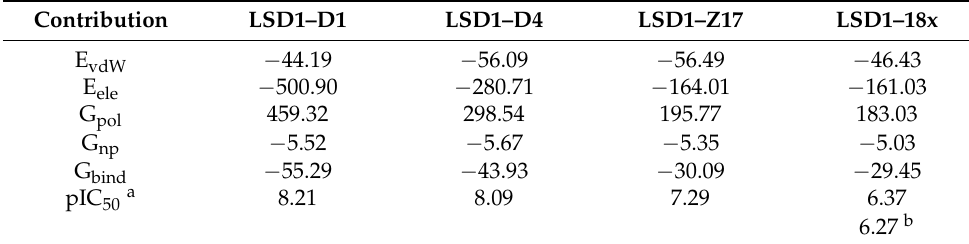
Table 6. Binding free energies of protein–ligand complexes